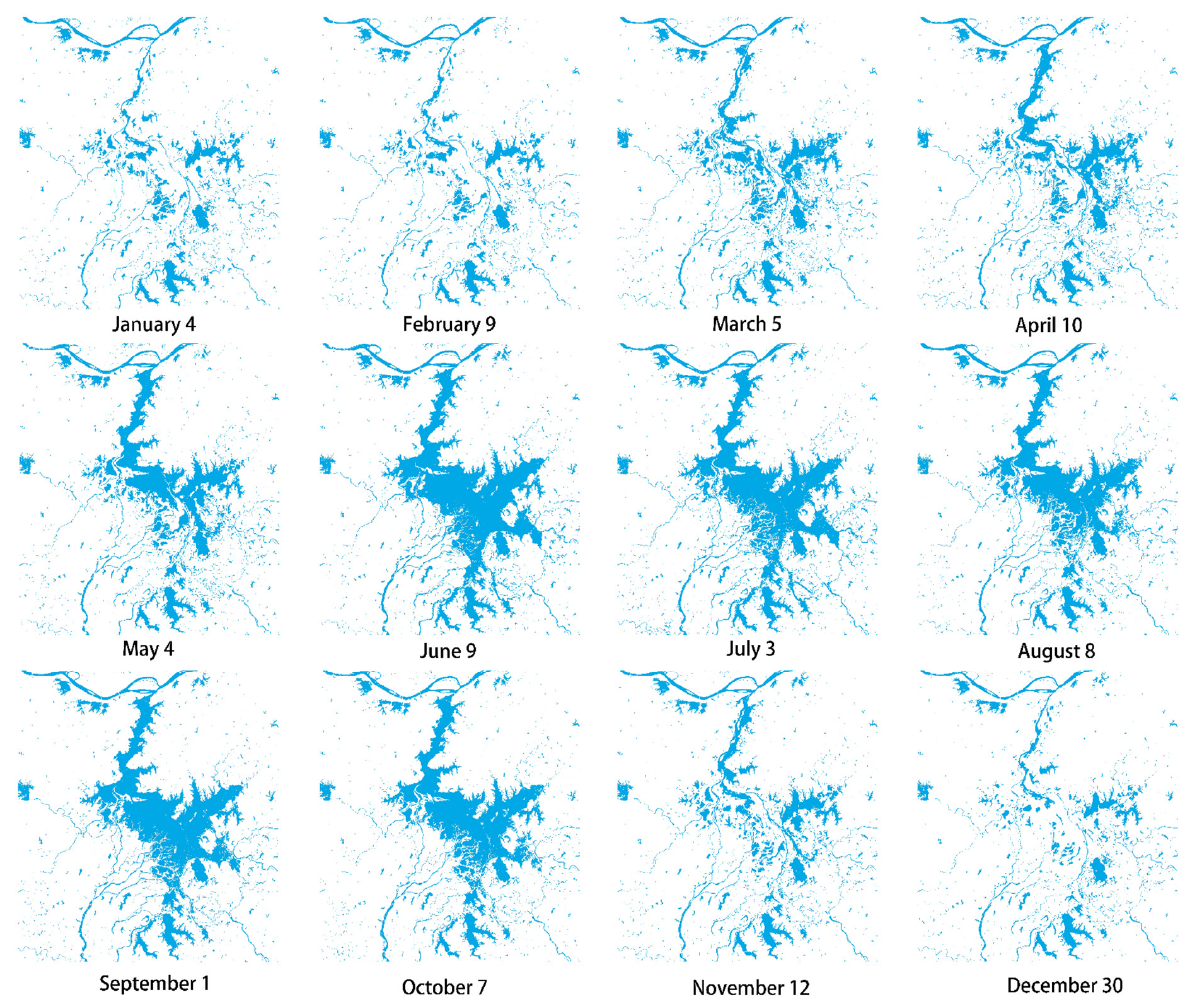
Figure 15. Sequence diagram of temporal and spatial variations of Poyang Lake in 2021.